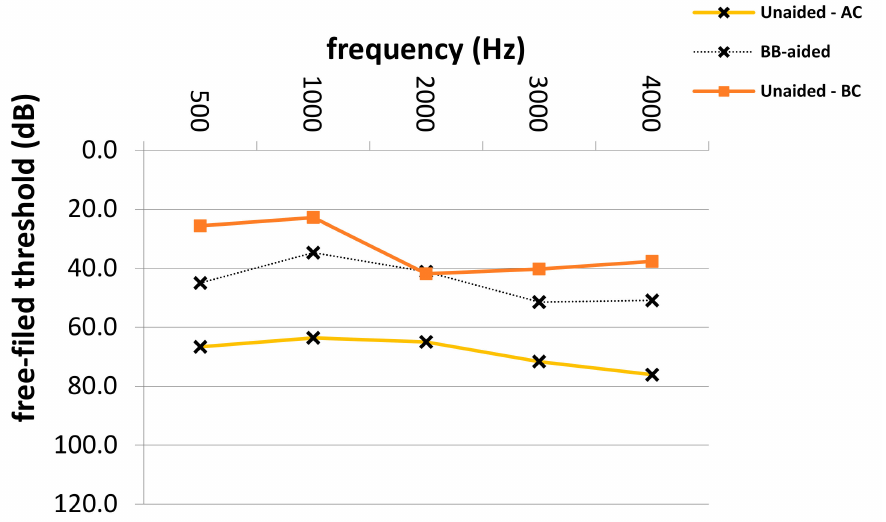
Figure 4. Aided and unaided free-field thresholds in patients with combined hearing loss. Hz; Hertz, dB; Decibel, Bb-aided; Bonebridge-aided free-field audiometry thresholds, Unaided–AC; unaided air conduction audiometry thresholds, Unaided–BC; unaided bone-conduction audiometry